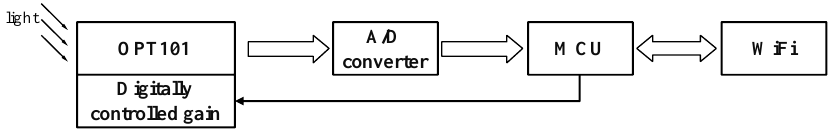
Figure 6. Overall design of the hardware circuit.